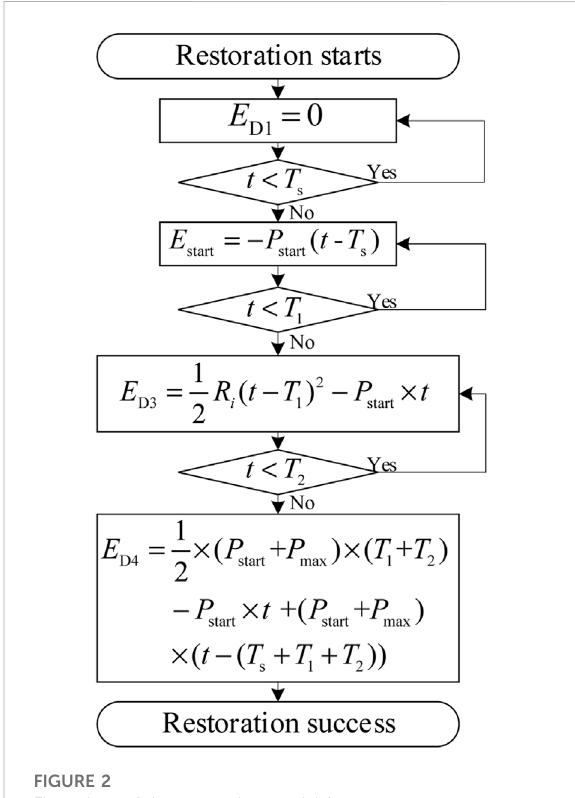
represents the power input to the system of the generator without Figure 1, the output electric energy of the non-black-start generator in the time interval [0, T ] can be obtained as: While the real time t ∈ ( 0 ,T s ) , the generator is in the standby state (D1), and the generator in this stage neither absorbs power nor outputs power to the system.